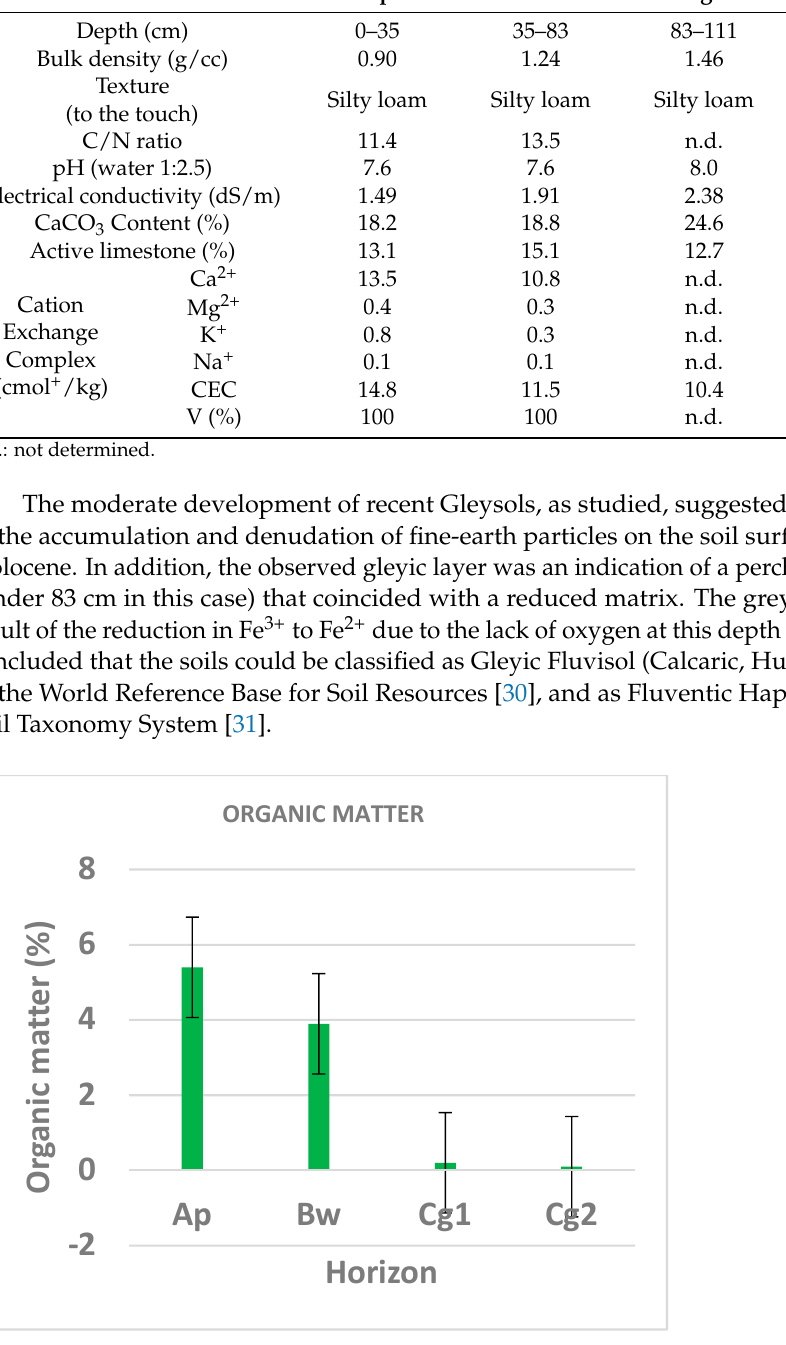
Table 2. Chemical and physicochemical characteristics of the investigated soil.